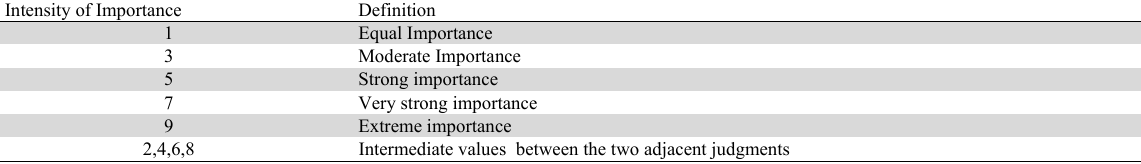
Nine-point intensity of importance scale Intensity of Importance